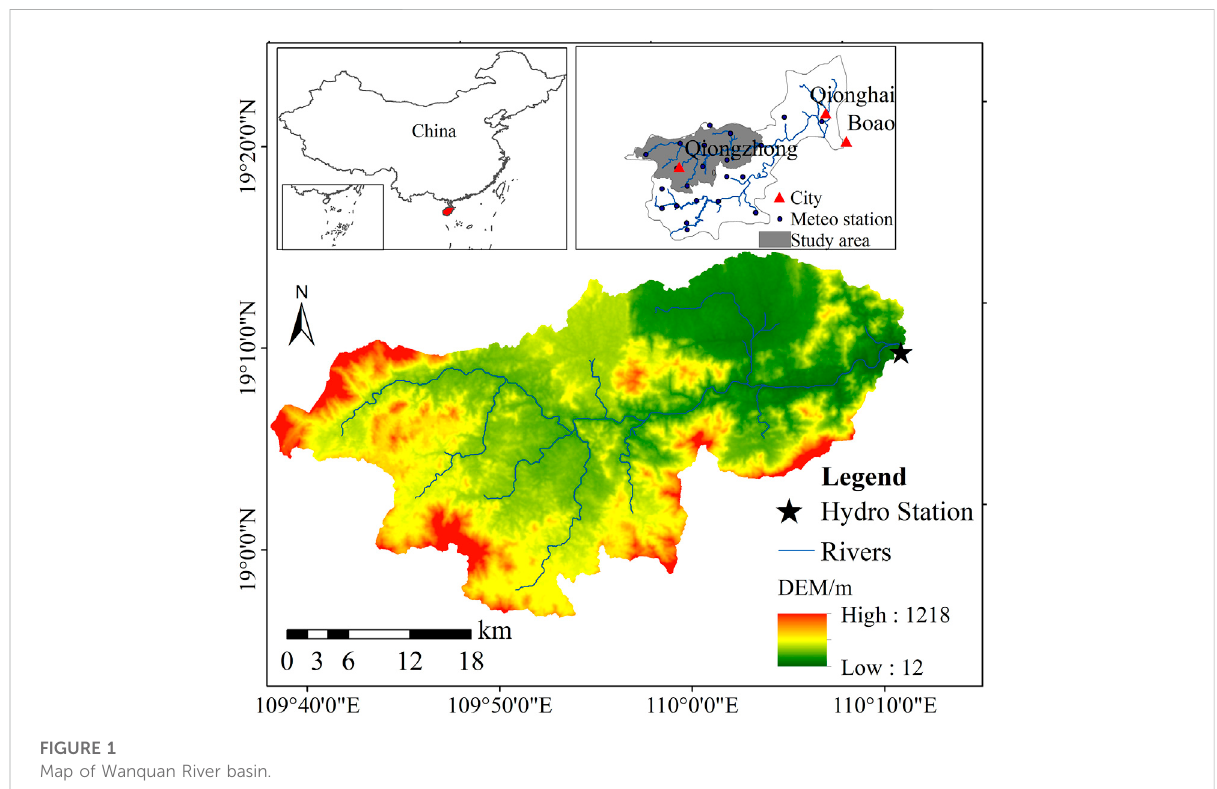
FIGURE 1 Map of Wanquan River basin.